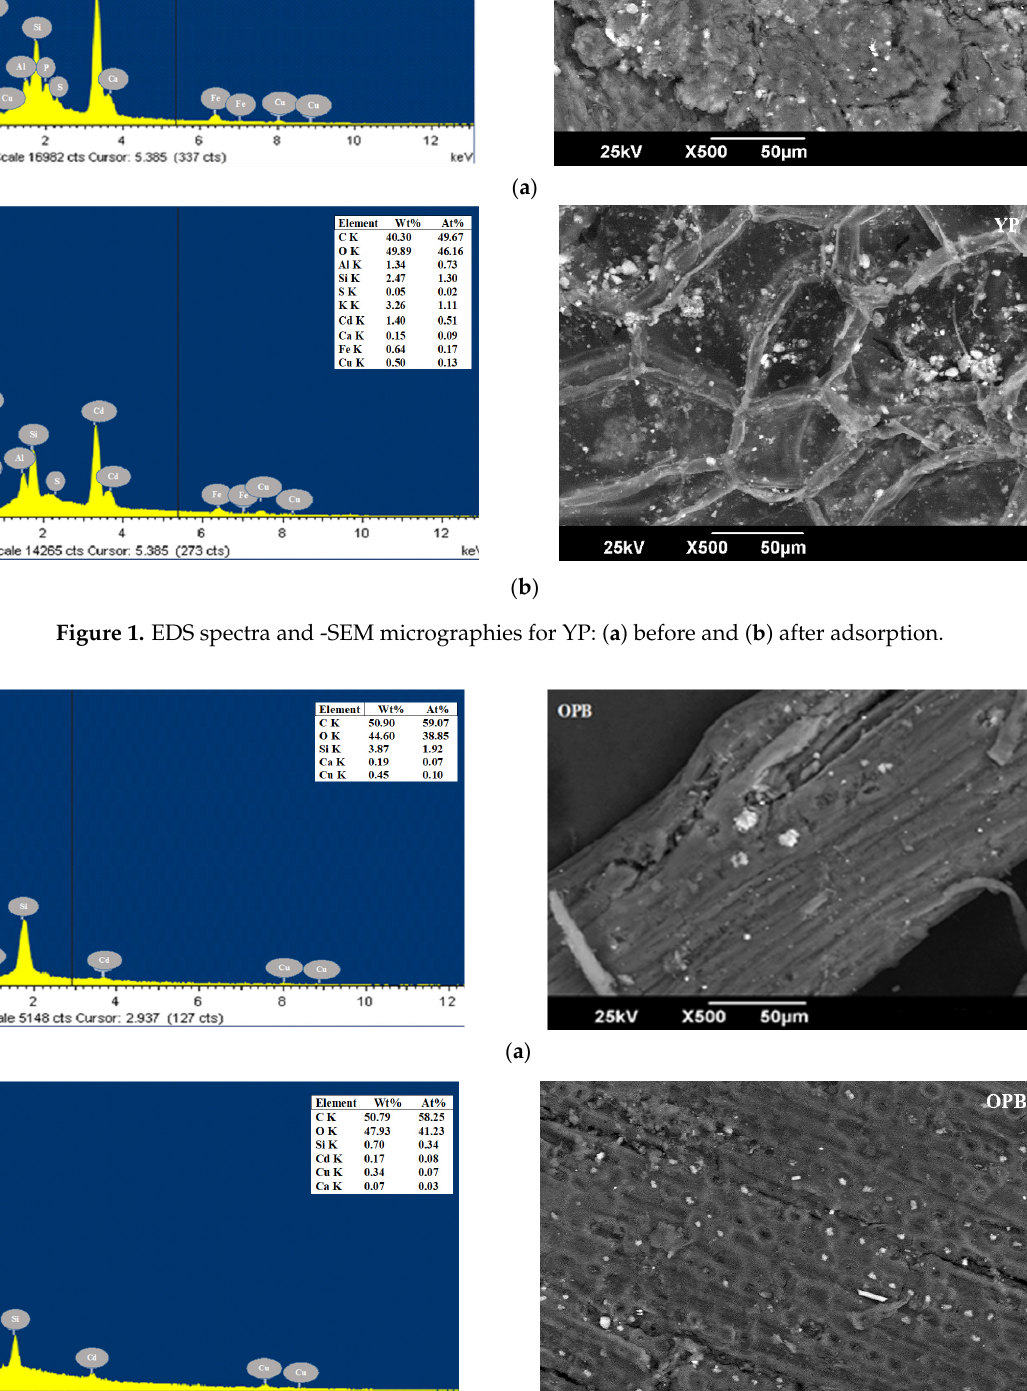
( a ) ( b ) Figure 3. EDS spectra and -SEM micrographies for CH: ( a ) before and ( b ) after adsorption.